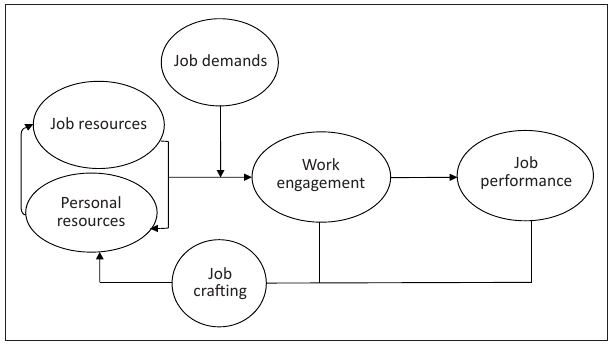
FIGURE 1: The job demands-resources model of work